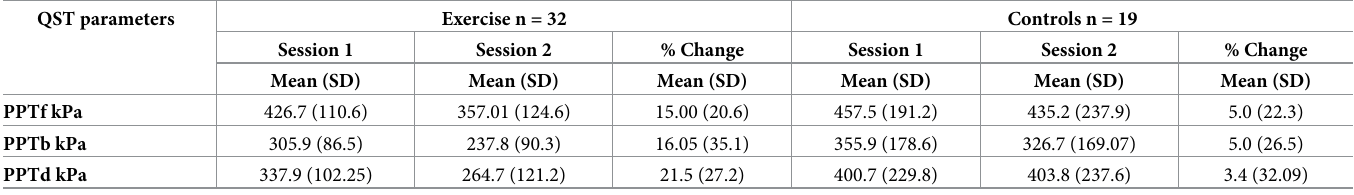
Table 2. PPT’s values at baseline (1 st session) and following 24 hours (2 nd session). QST